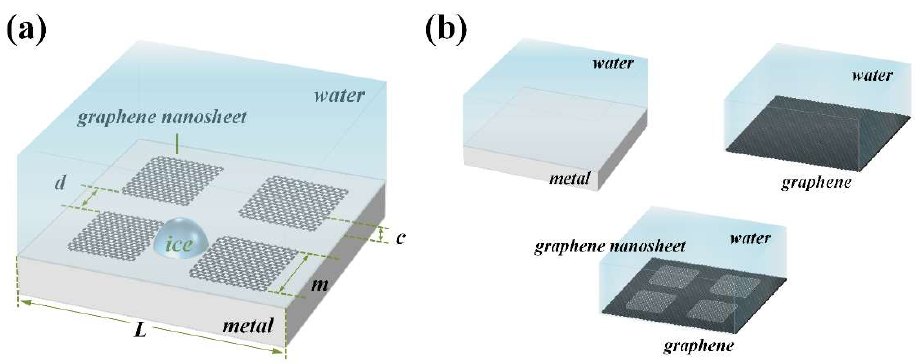
Figure 1. Illustrations of simulation systems. ( a ) Model of the metal–graphene nanosheet surface that was covered with a box of liquid water. A typical ice nucleus formation is illustrated on the surface. ( b ) Models of three other simulation systems. Pure metal, pure graphene and graphene–graphene nanosheet surface systems.